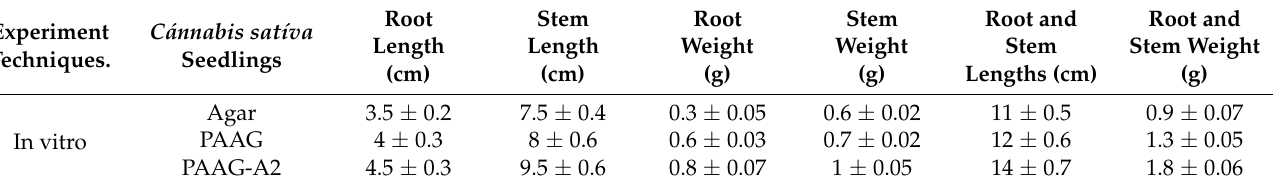
Table 4. Metric indicators of Cánnabis satíva seedlings.